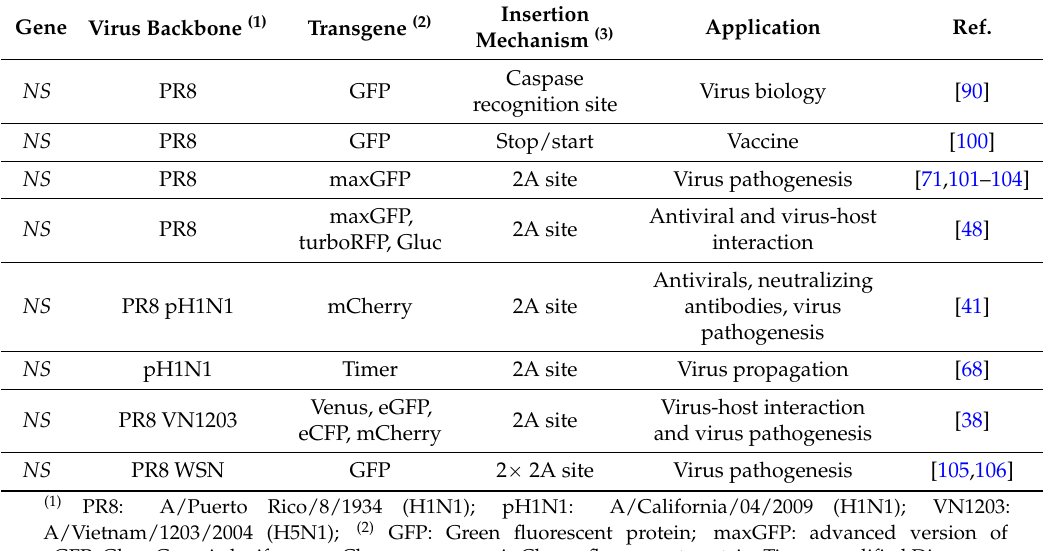
Table 7. Recombinant influenza A viruses expressing reporter genes from the NS viral segment. Gene Virus Backbone